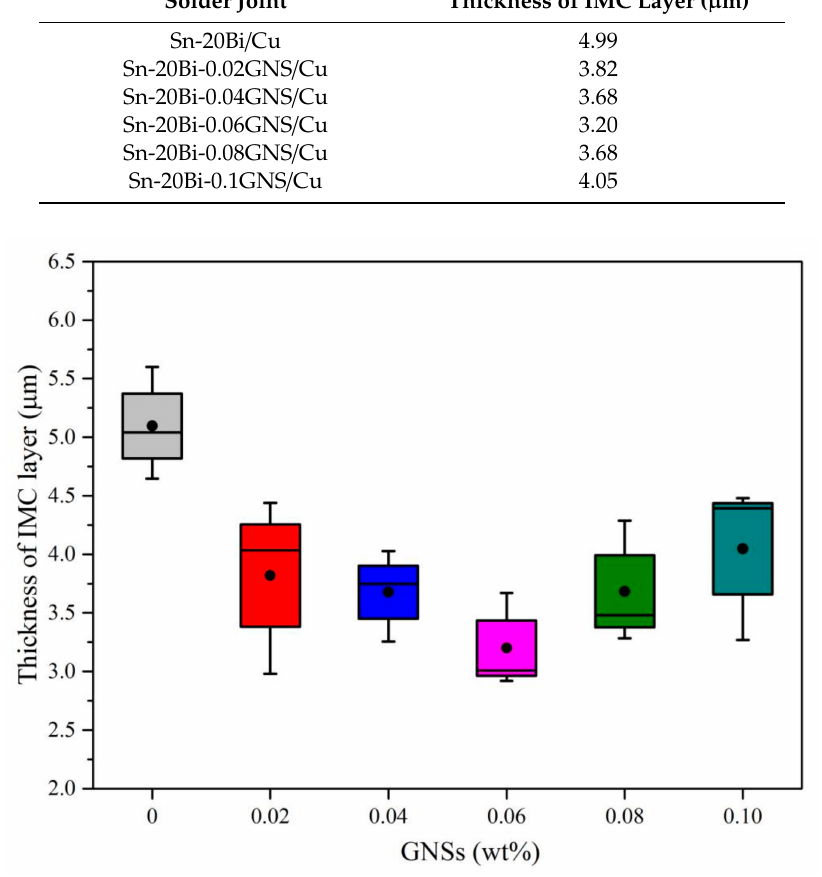
Figure 7. Thickness of IMC layer at Sn-20Bi-xGNS / Cu solder